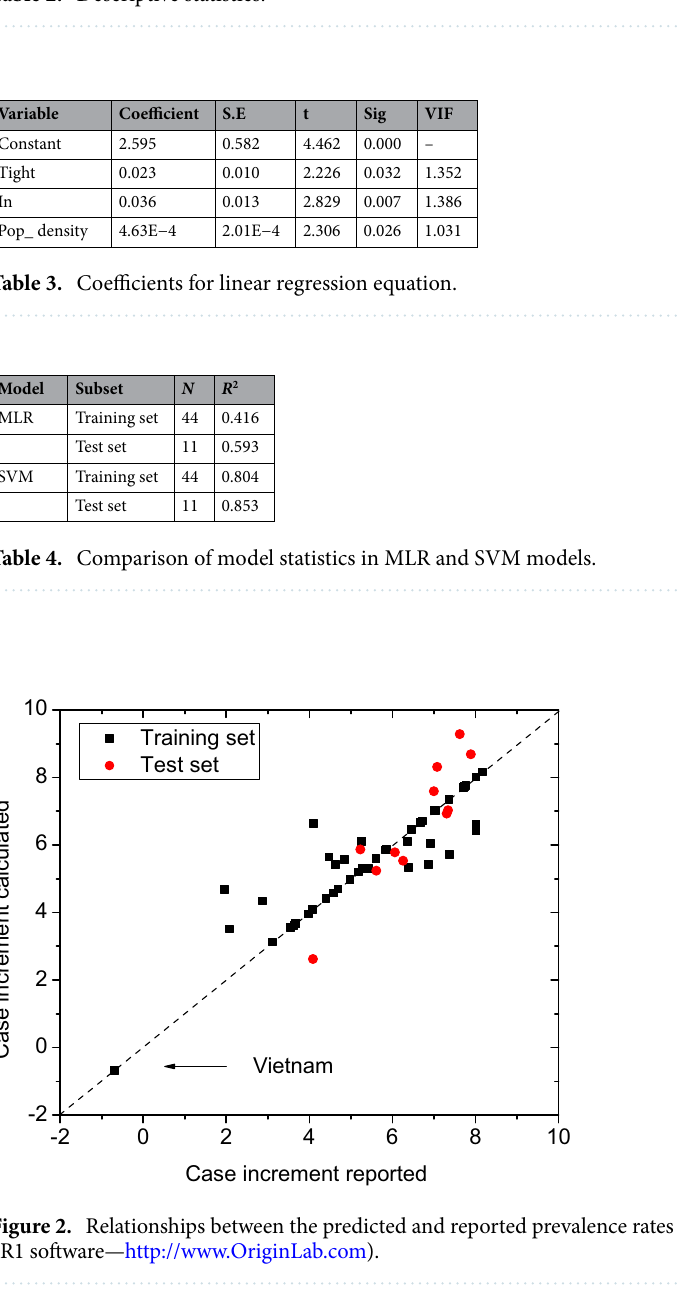
Table 2. Descriptive statistics.